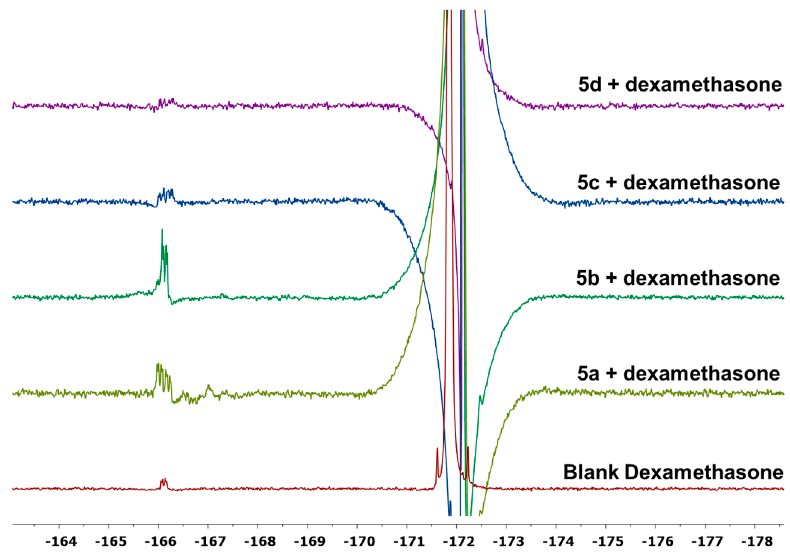
Figure 7. 19 F NMR spectra of dexamethasone encapsulated polymers ( 5a , 5b , 5c , and 5d ) and blank dexamethasone in deuterated methanol; 5-fluorouracil (2 mg/mL) used as internal reference.